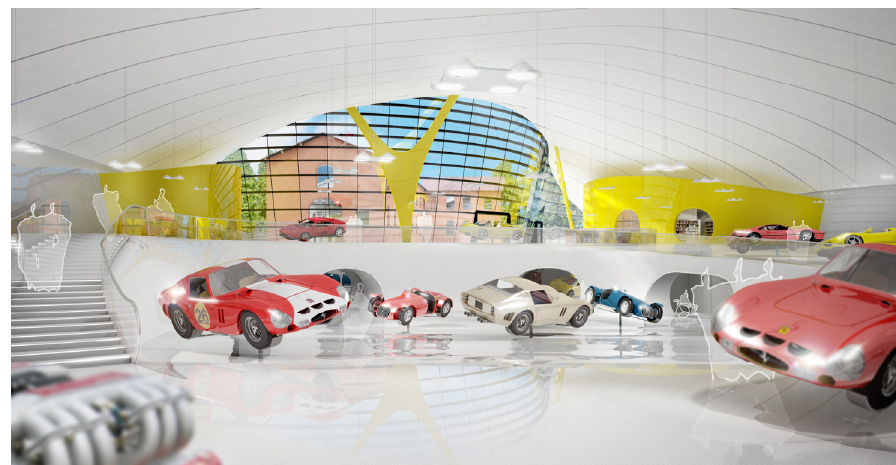
Figure 10: Ferrari & Maserati Museum, Modena -